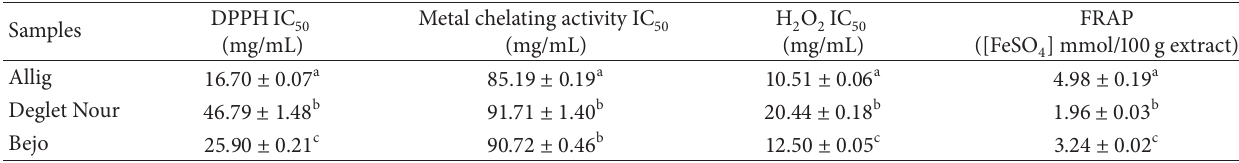
Table 2: Comparison of antioxidant properties of date extracts.